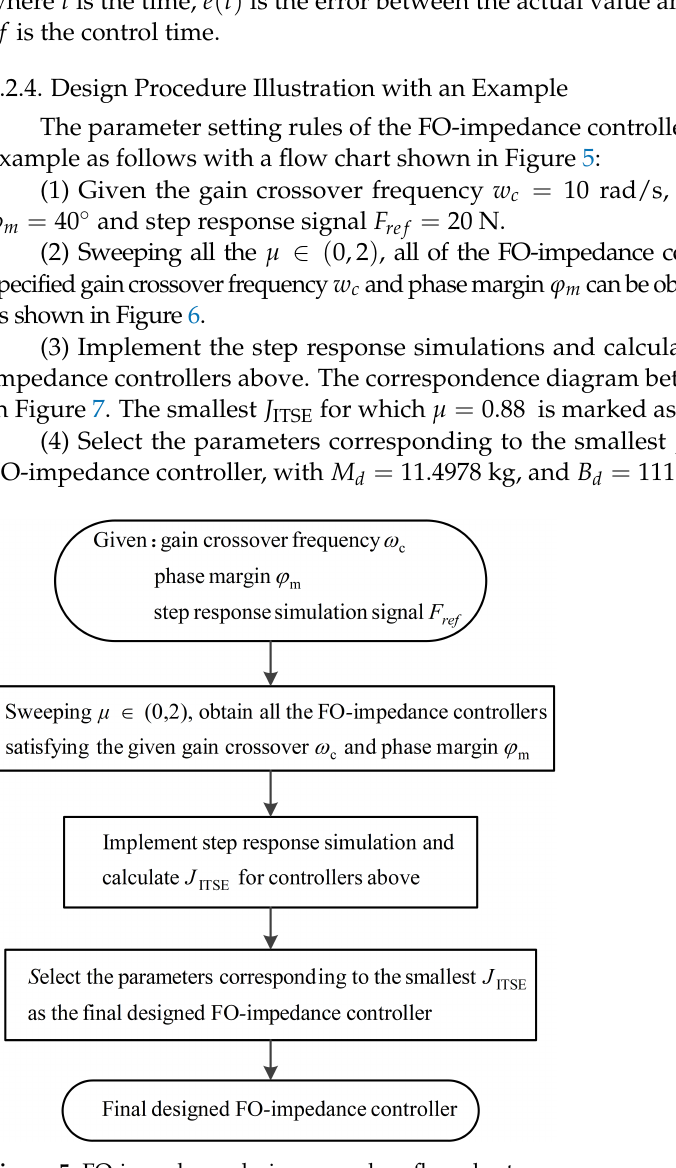
Figure 5. FO-impedance design procedure flow chart.